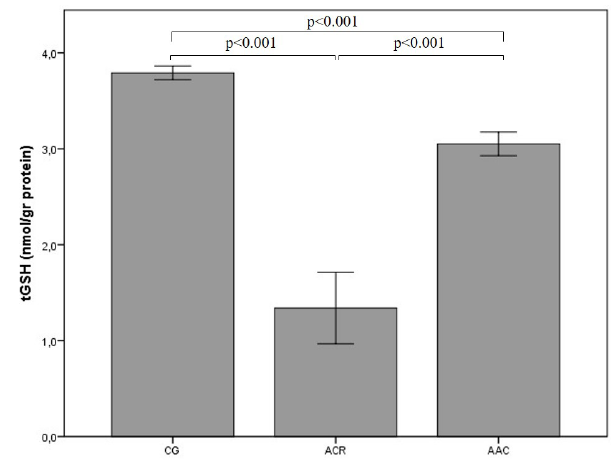
FIGURE 3 - Comparison of the tGSH levels between the study groups. Bars represent mean ± standard deviation. CG control group, ACR acrylamide-treated group, AAC anakinra + acrylamide-treated